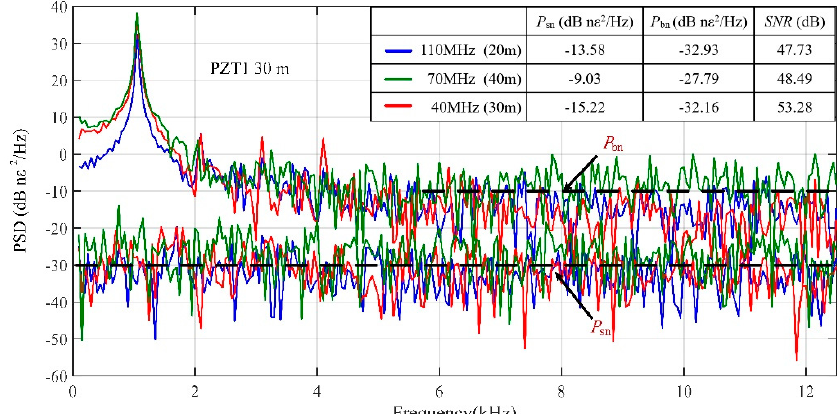
Figure 7. The power spectra of demodulated phase difference change signal and background noise at piezoelectric transducer 1 (PZT1).